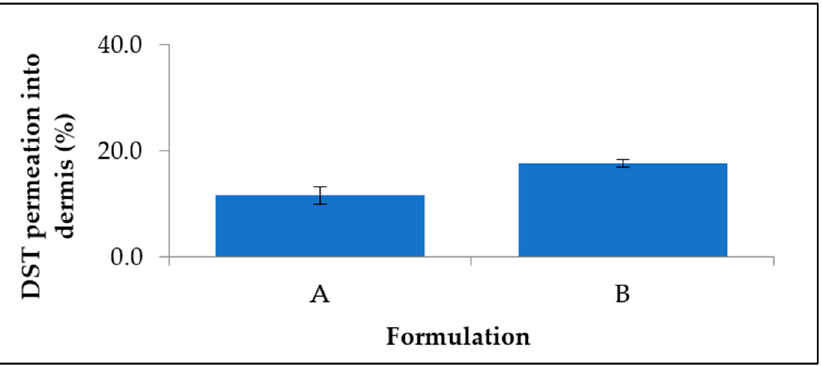
Figure 7. Comparison of dutasteride permeation from DST-LNP of Formulation A and B over 48 h.